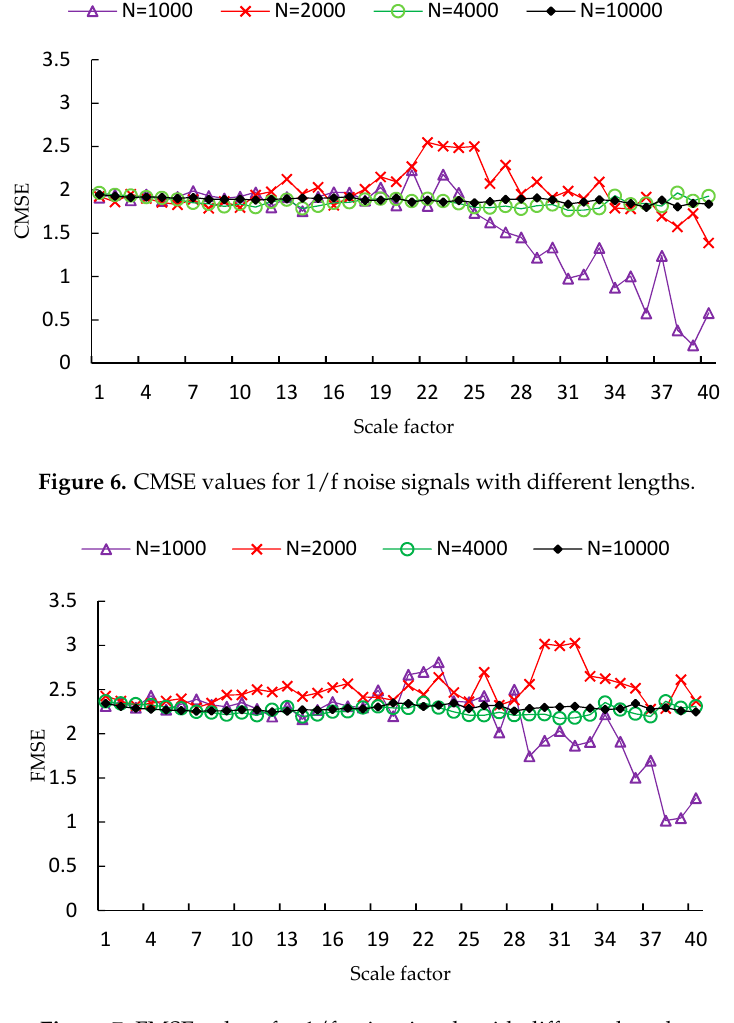
Figure 7. FMSE values for 1/f noise signals with different lengths.